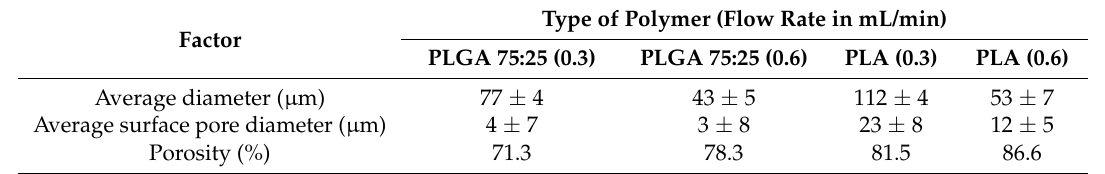
Table 3. Structure characterization of PLGA and PLA microspheres obtained in microfluidics method with increased flow rates regimen, p < 0.01. The average diameters and porosity (%) were calculated based on SEM images with image analysis software ImageJ and weight ratios as depicted in Section 2.6.